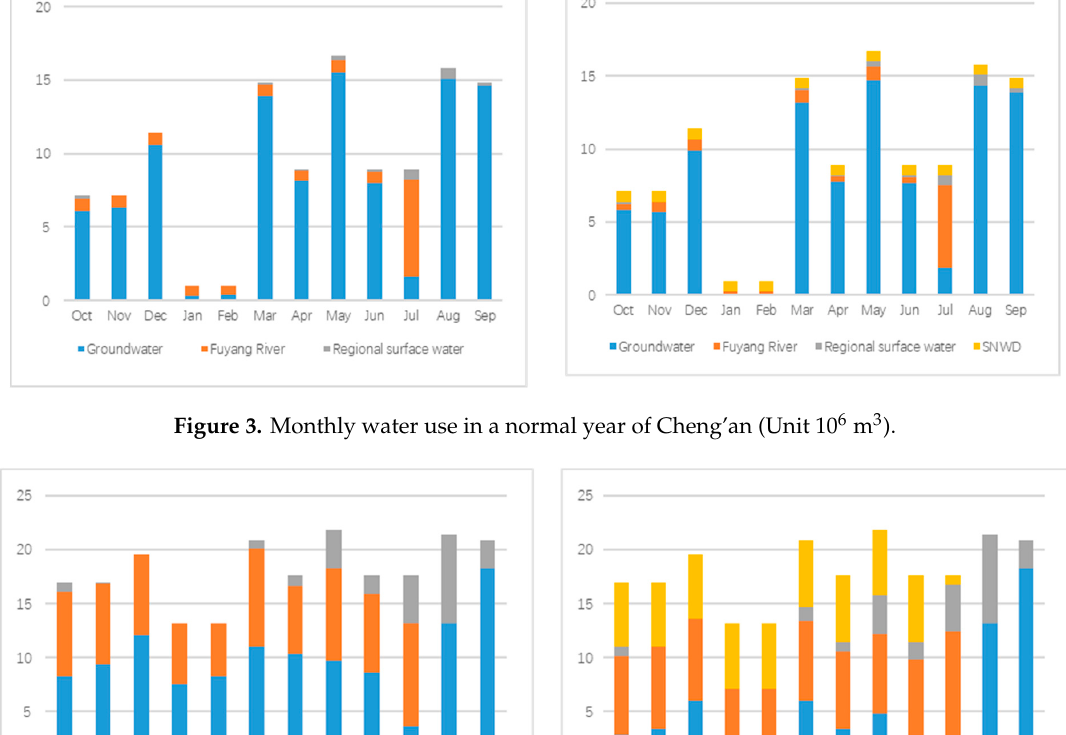
Figure 4. Monthly water use in a normal year of Handan (Unit 10 6 m 3 ).